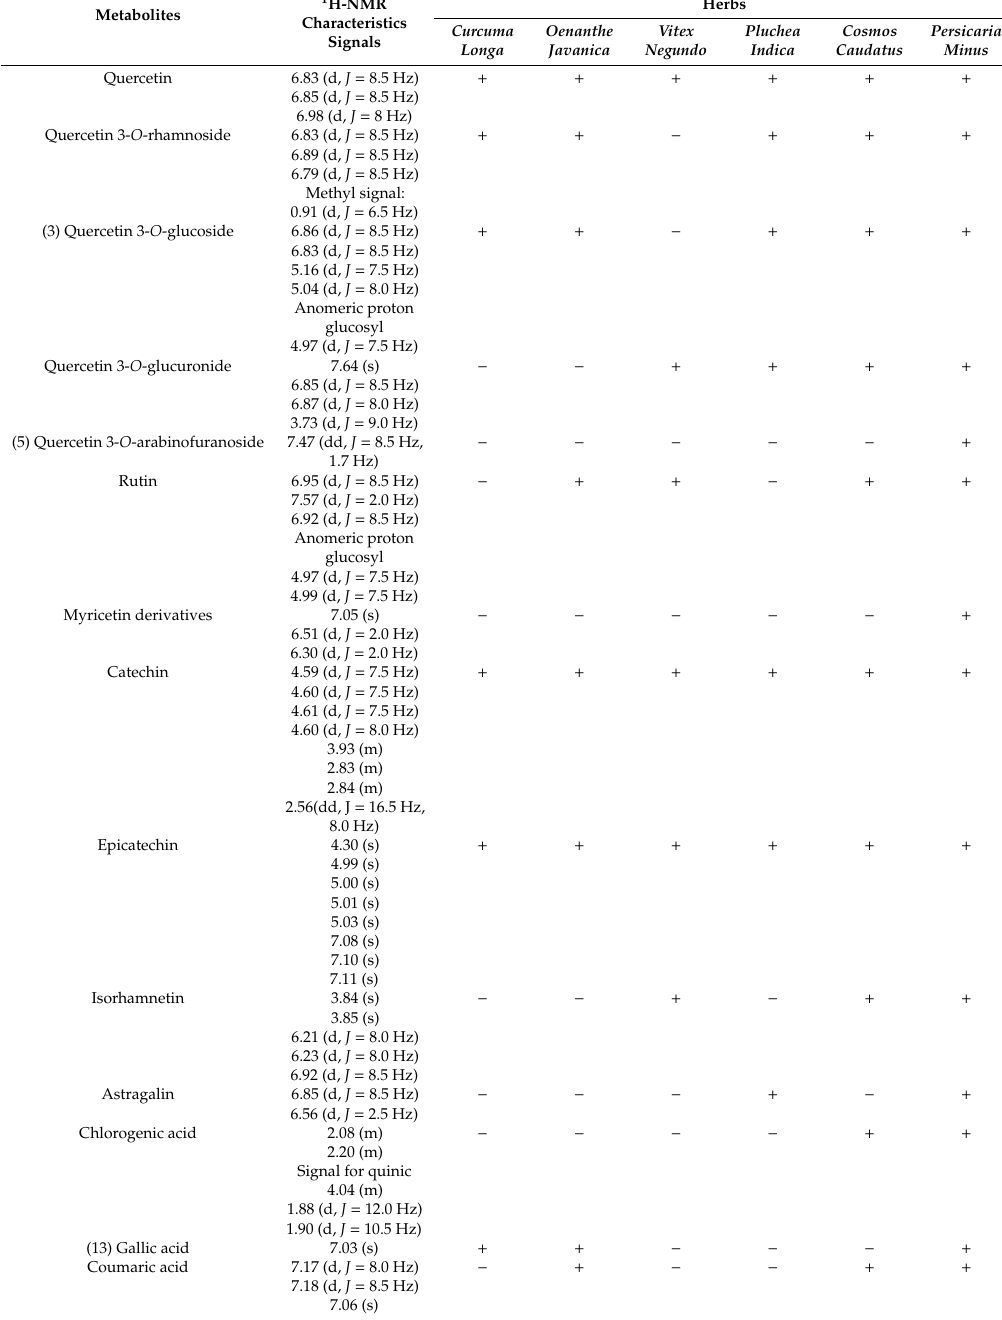
Table 1. 1 H-NMR characteristic signals of identified metabolites in selected herbs.